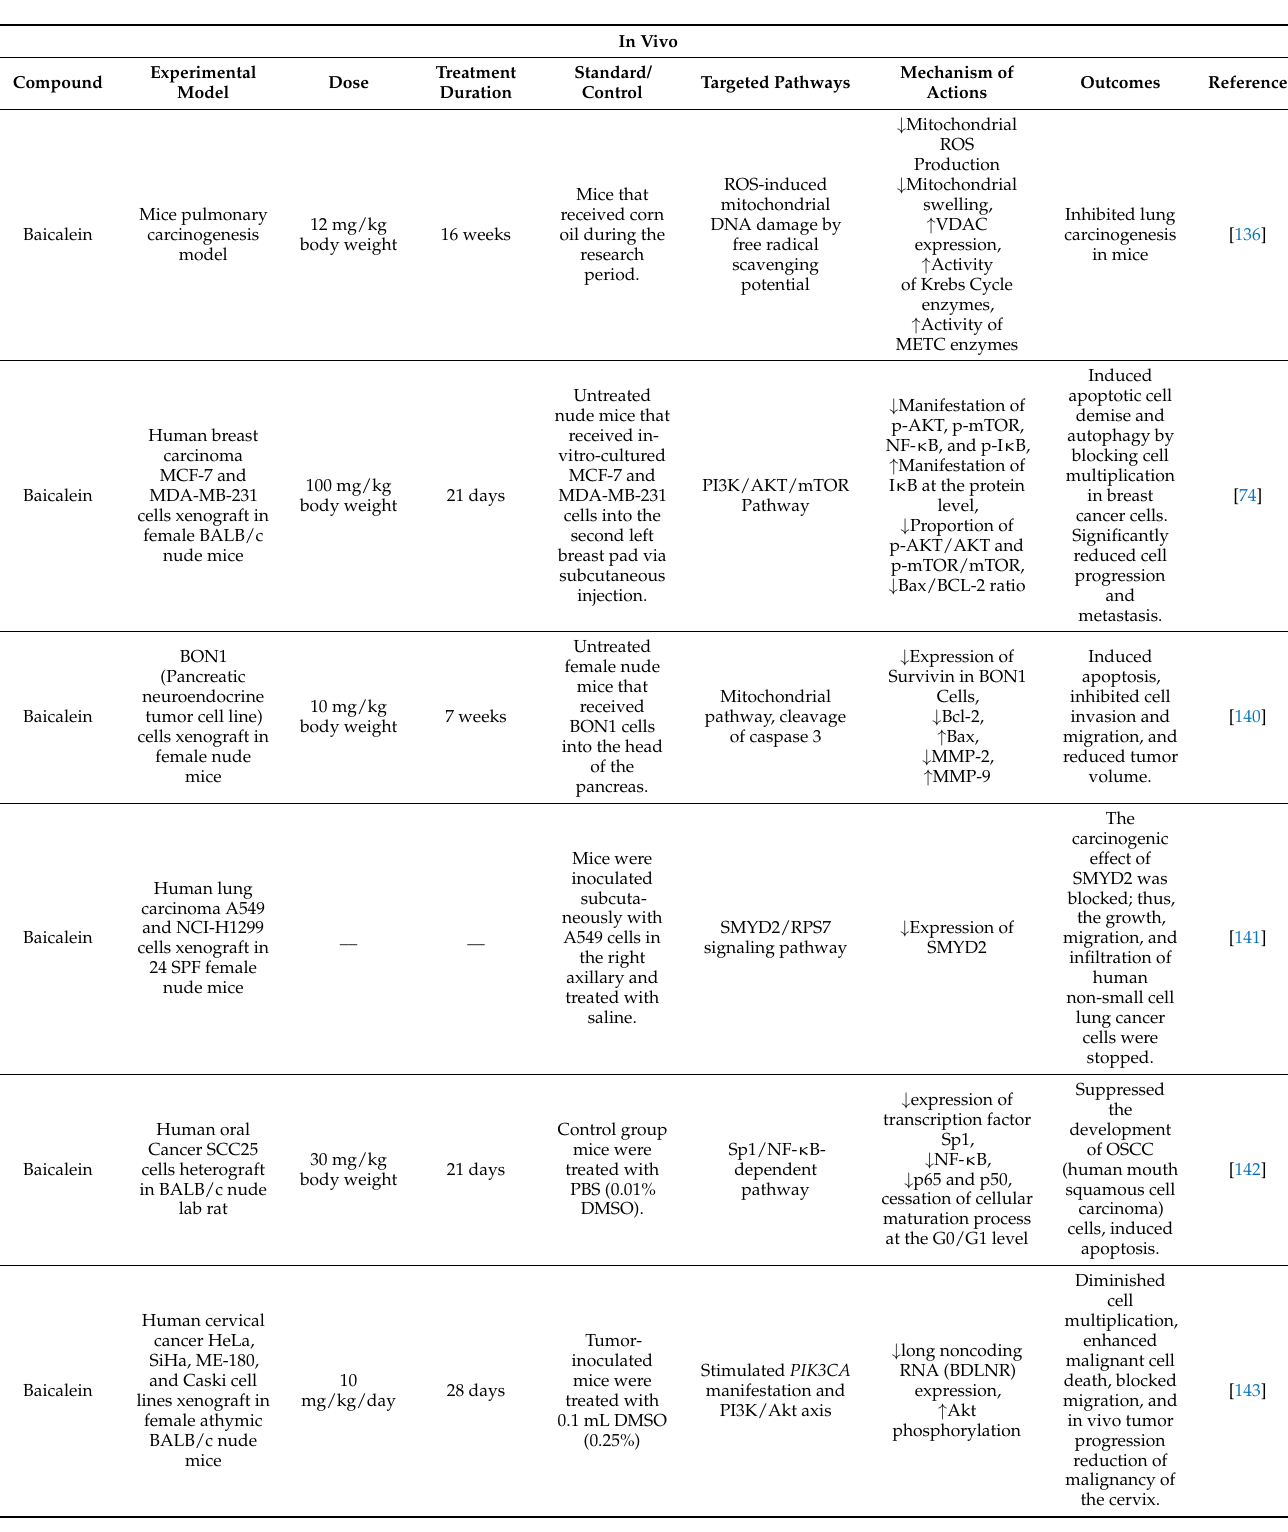
Table 1. Effects of Baicalein on cancer